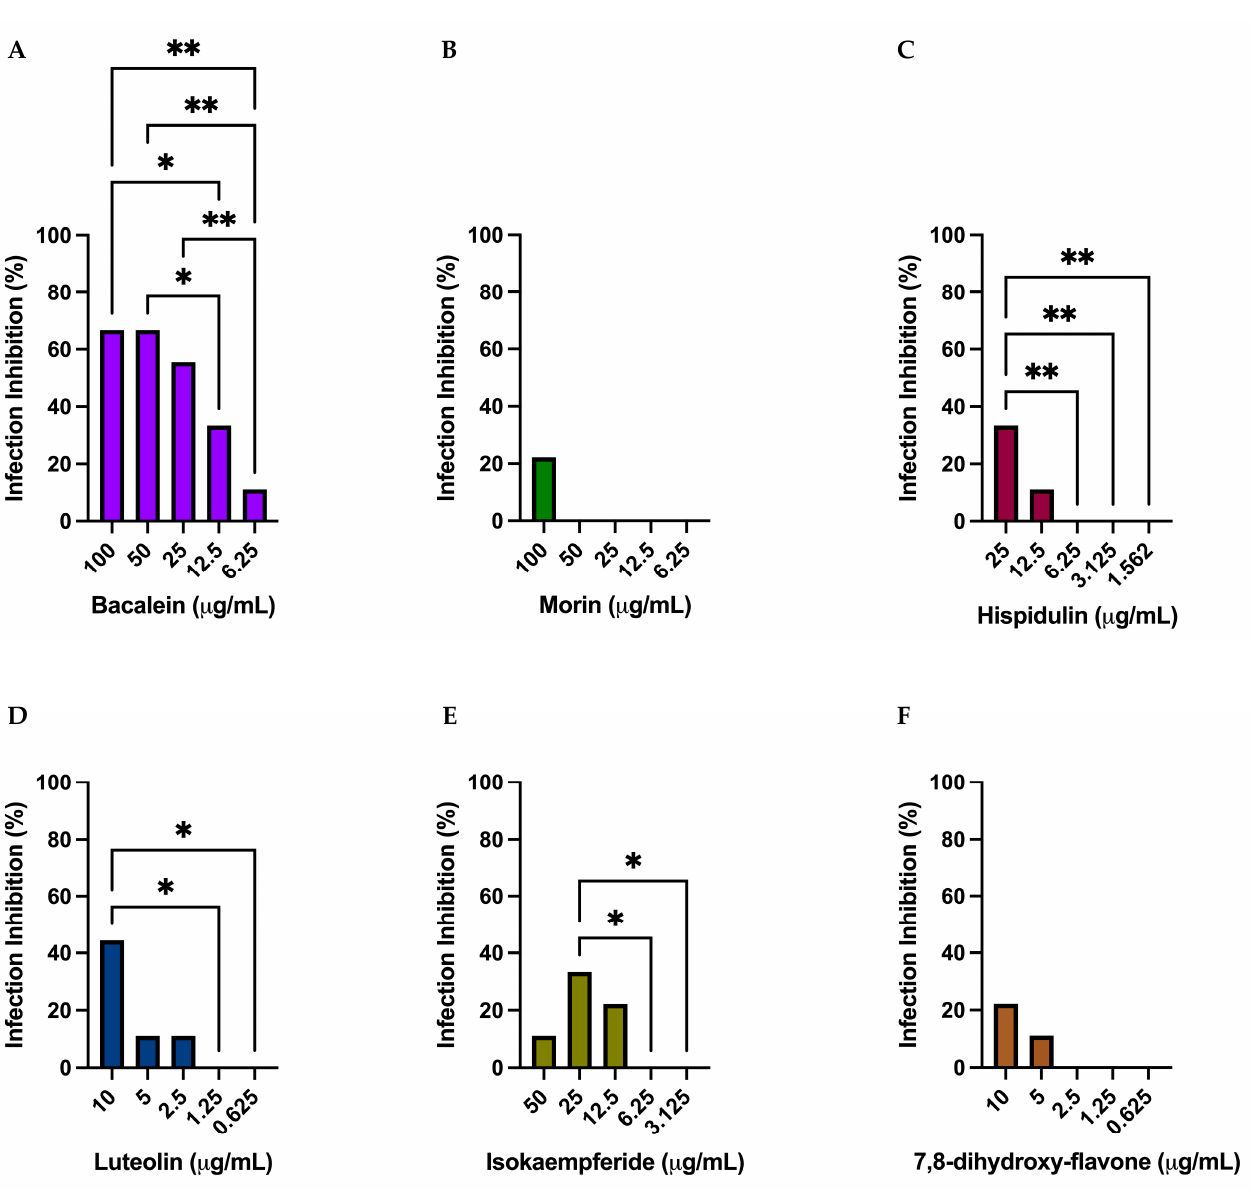
Figure 2. ( A – F ) Antiviral activity of selected 3CLpro inhibitors. The inhibition of Omicron BA.5 infection was tested using different concentrations of the selected compounds and was assessed at 72 hpi. Mean values are reported for all the experimental replicates. Standard deviations were less than 10% of the mean values. An ordinary one-way ANOVA with a Tukey’s multiple comparisons test, with a single pooled variance, was performed. * p < 0.05 and ** p < 0.01.